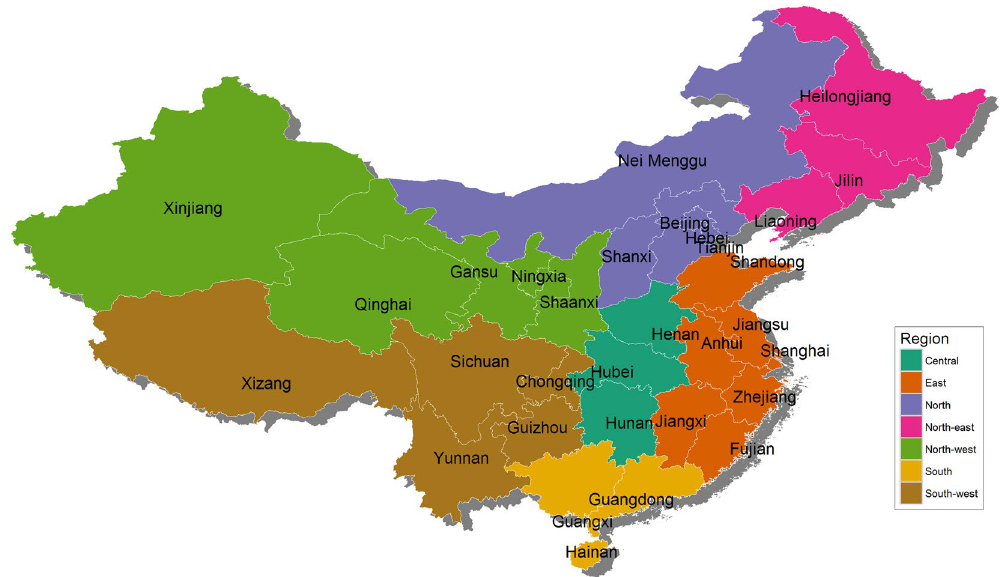
Figure 2. Seven regions from 31 provinces of mainland China. Thirty-one provincial-level divisions of mainland China were grouped as Central, East, North, Northeast, Northwest, South and Southwest China. Geographic data for mainland China was obtained from “Global Administrative Areas” (http://www.gadm.org/ home). Map was created using R version 3.3.1